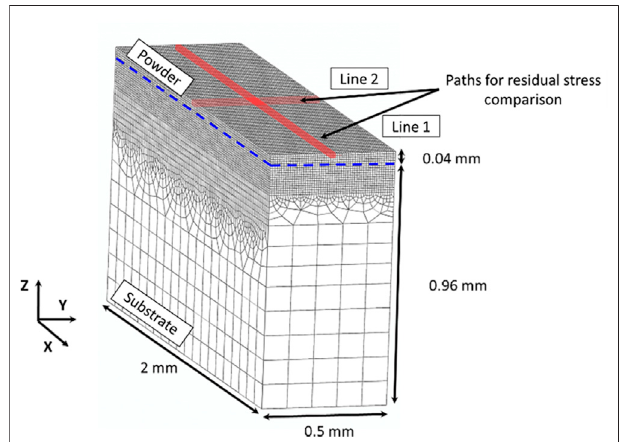
FIGURE 2 | Track-scale model mesh showing the dimensions of the substrate and powder bed. The laser movement is parallel to the X -direction. The residual stresses are evaluated along the two lines highlighted in